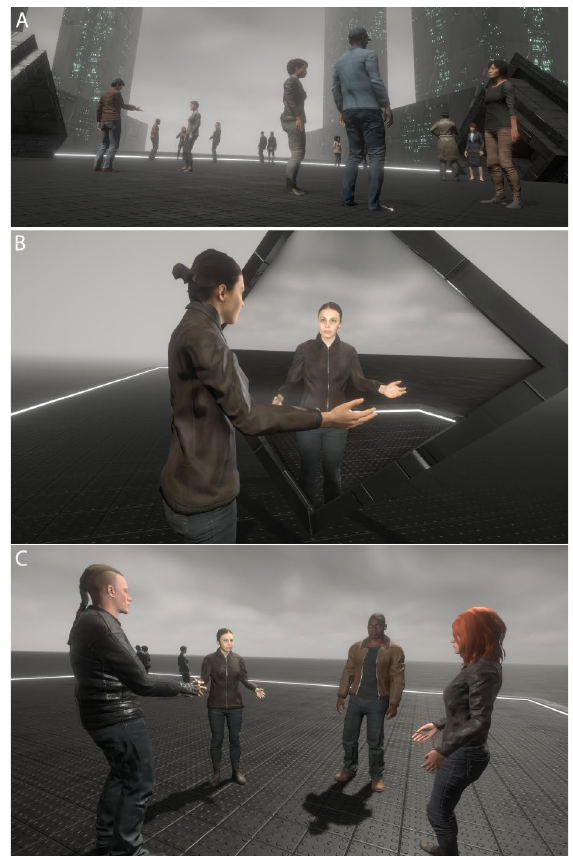
Figure 1. The scenario ( A ) The square between the tall buildings showing the groups. ( B ) A participant sees her body-double in front of the mirror during the embodiment phase before it goes out to the crowd. ( C ) The participant interacting with one of the